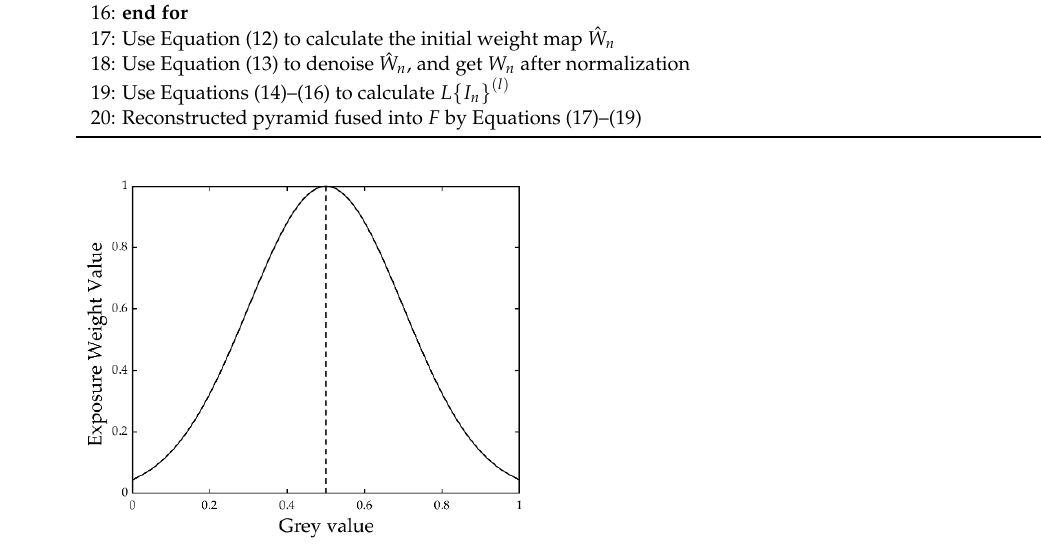
Figure 2. Gaussian